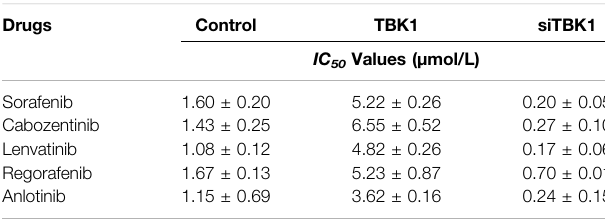
TABLE 5 | The effect of TBK1 overexpression or knockdown on the sensitivity of HepG2 cells to molecular-target drugs, Sorafenib, Cabozentinib, Lenvatinib, Regorafenib or Anlotinib.